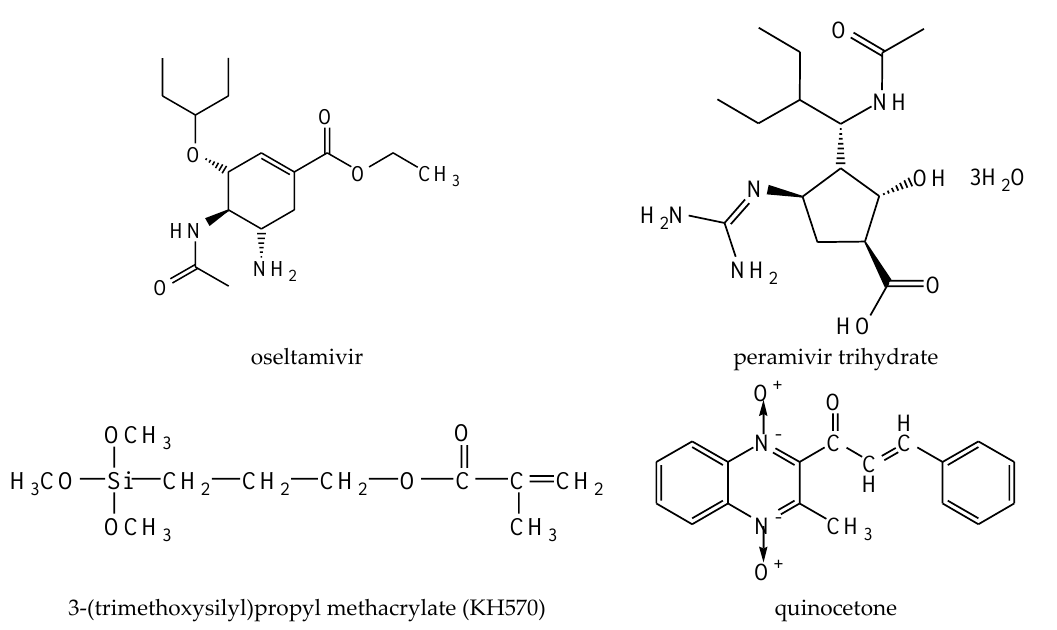
( d ) Figure 3. Kinetic adsorption curves of OS on OSMIP@silica gel and NIP@silica gel ( a ), static adsorption of OS on OSMIP@silica gel and NIP@silica gel ( b ), Scatchard plot for OS on OSMIP@silica gel ( c ) and NIP@silica gel ( d ). 2.3. Specific Affinity of the OSMIP@silica Gel LC Column To develop a biological replacement method of screening for antiviral drugs, the MIP was